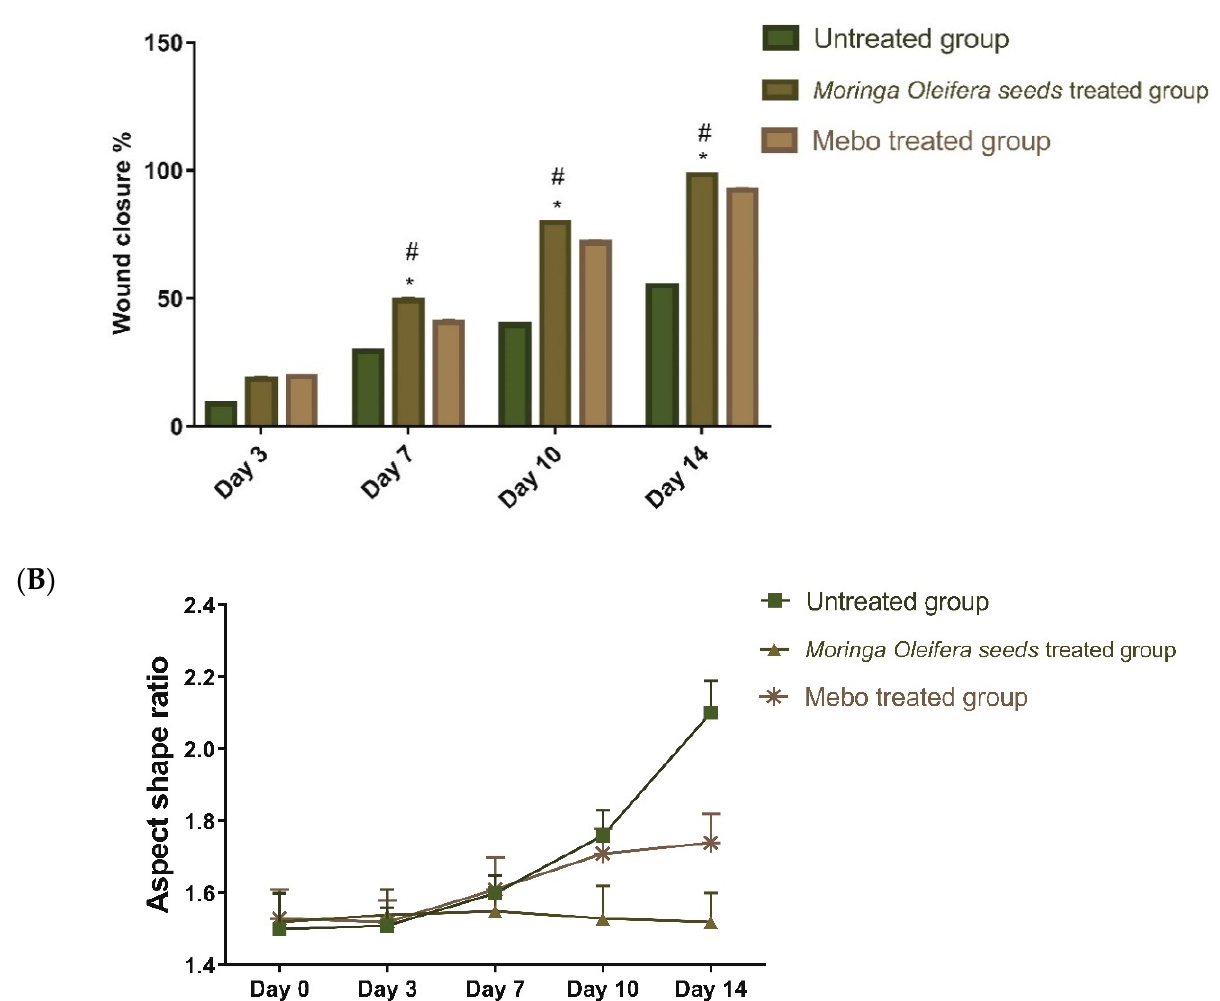
Figure 2. ( A ). Wound closure rates over time post-injury in all investigated groups. Group 1 was left untreated (-ve control). Group 2 received Moringa oleifera seeds extract. Group 3 received MEBO ® (marketed treatment- + ve control over 0, 3, 7, 10, and 14 days). After normalizing the variables using the Shapiro–Wilk test, a two-way ANOVA test was used to examine significant differences between groups. The expression of the data was expressed as mean ± SD. In comparison to the respective day’s untreated group, * p < 0.001; in comparison to the respective day’s MEBO ® group, # p < 0.001. ( B ) Wound aspect ratio was determined to describe observed changes in the shape and direction of wound contraction between groups (length:width).